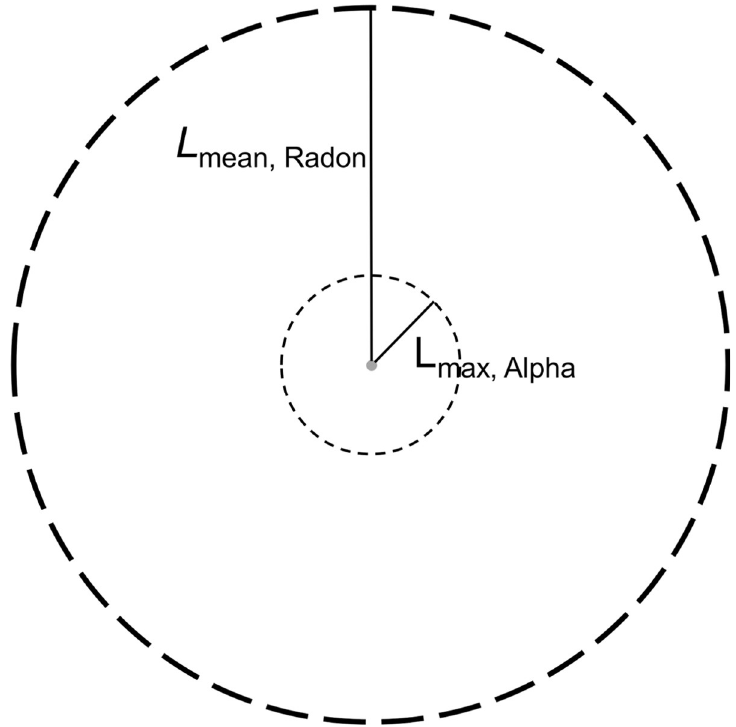
Fig 7. Illustration of the maximum distance alpha particles can travel in water (L max, Alpha = 100 μ m) and estimated mean diffusion length of 220 Rn in water (L mean, Radon = 300–400 μ m) relative to the CaCO 3 microparticle size (5 μ m in